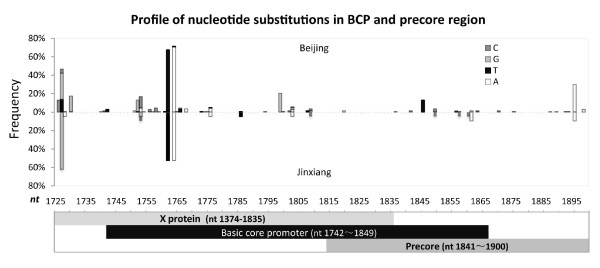
Nucleotide substitution profiles in BCP and preC. The top panel illustrates frequencies of all mutations in the BCP and preC of viral genomes. Hot spots of mutations are largely congruent in patients from Beijing (upper half) and Jinxiang (lower half) except for different mutation rates at certain positions. The bottom panel demonstrates the positions of the X gene, BCP and preC gene in the region. The overlapped part for all three regions is unlikely to mutate.